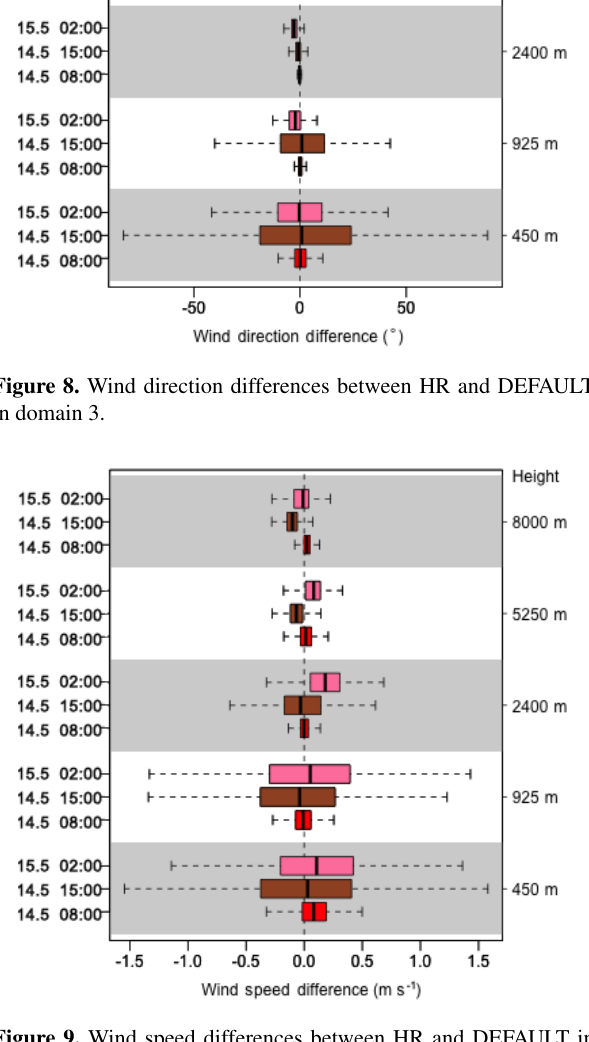
Figure 9. Wind speed differences between HR and DEFAULT in domain